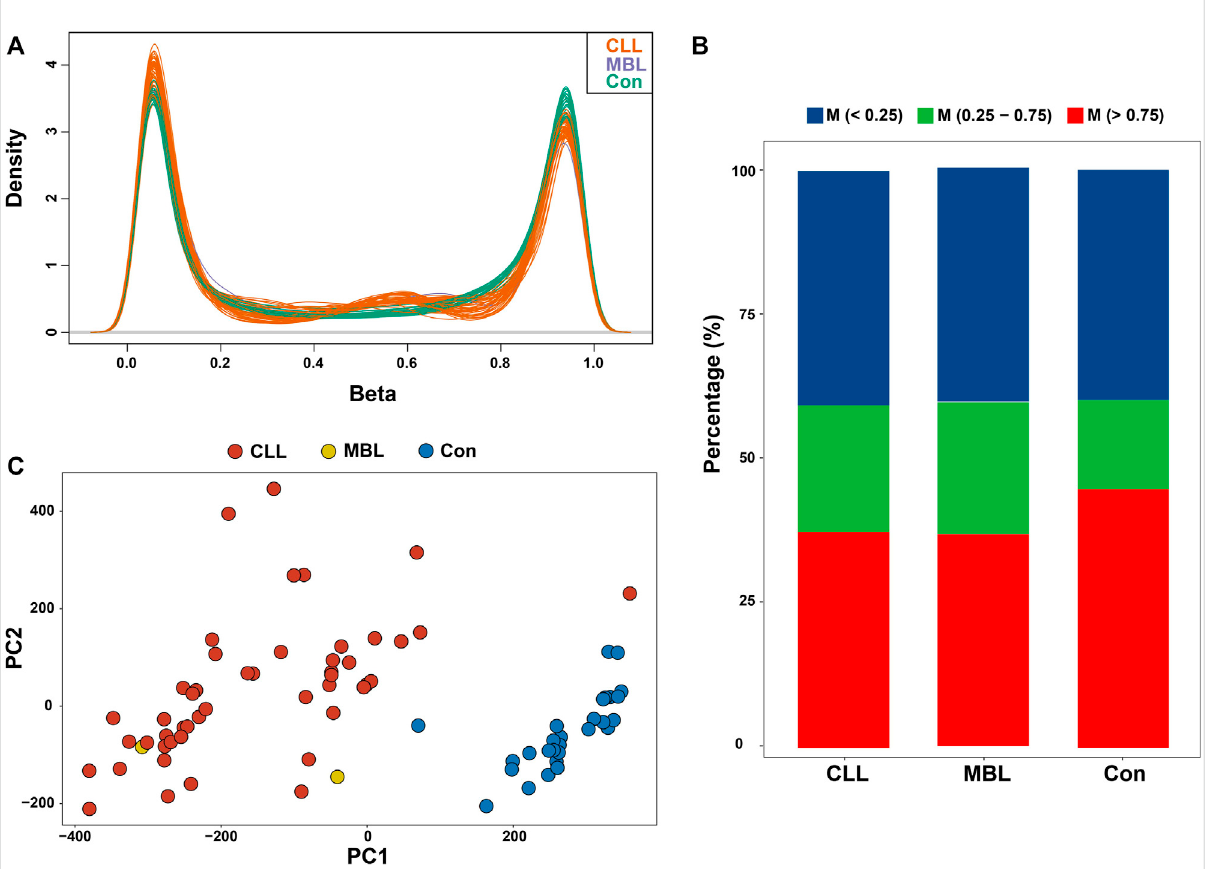
FIGURE 2 Whole-genome methylation pattern in our study (A) Density plot of methylation beta values of 48 CLL patients, two MBL patients, and 28healthycontrolafter quality control (B) Percentage ofbetavalueas threecategories( < 0.75, 0.25 – 0.7, and > 0.75) inCLL,MBL,and healthycontrol (C) Principal component analysis of all probes (N = 406,879) in CLL, MBL, and